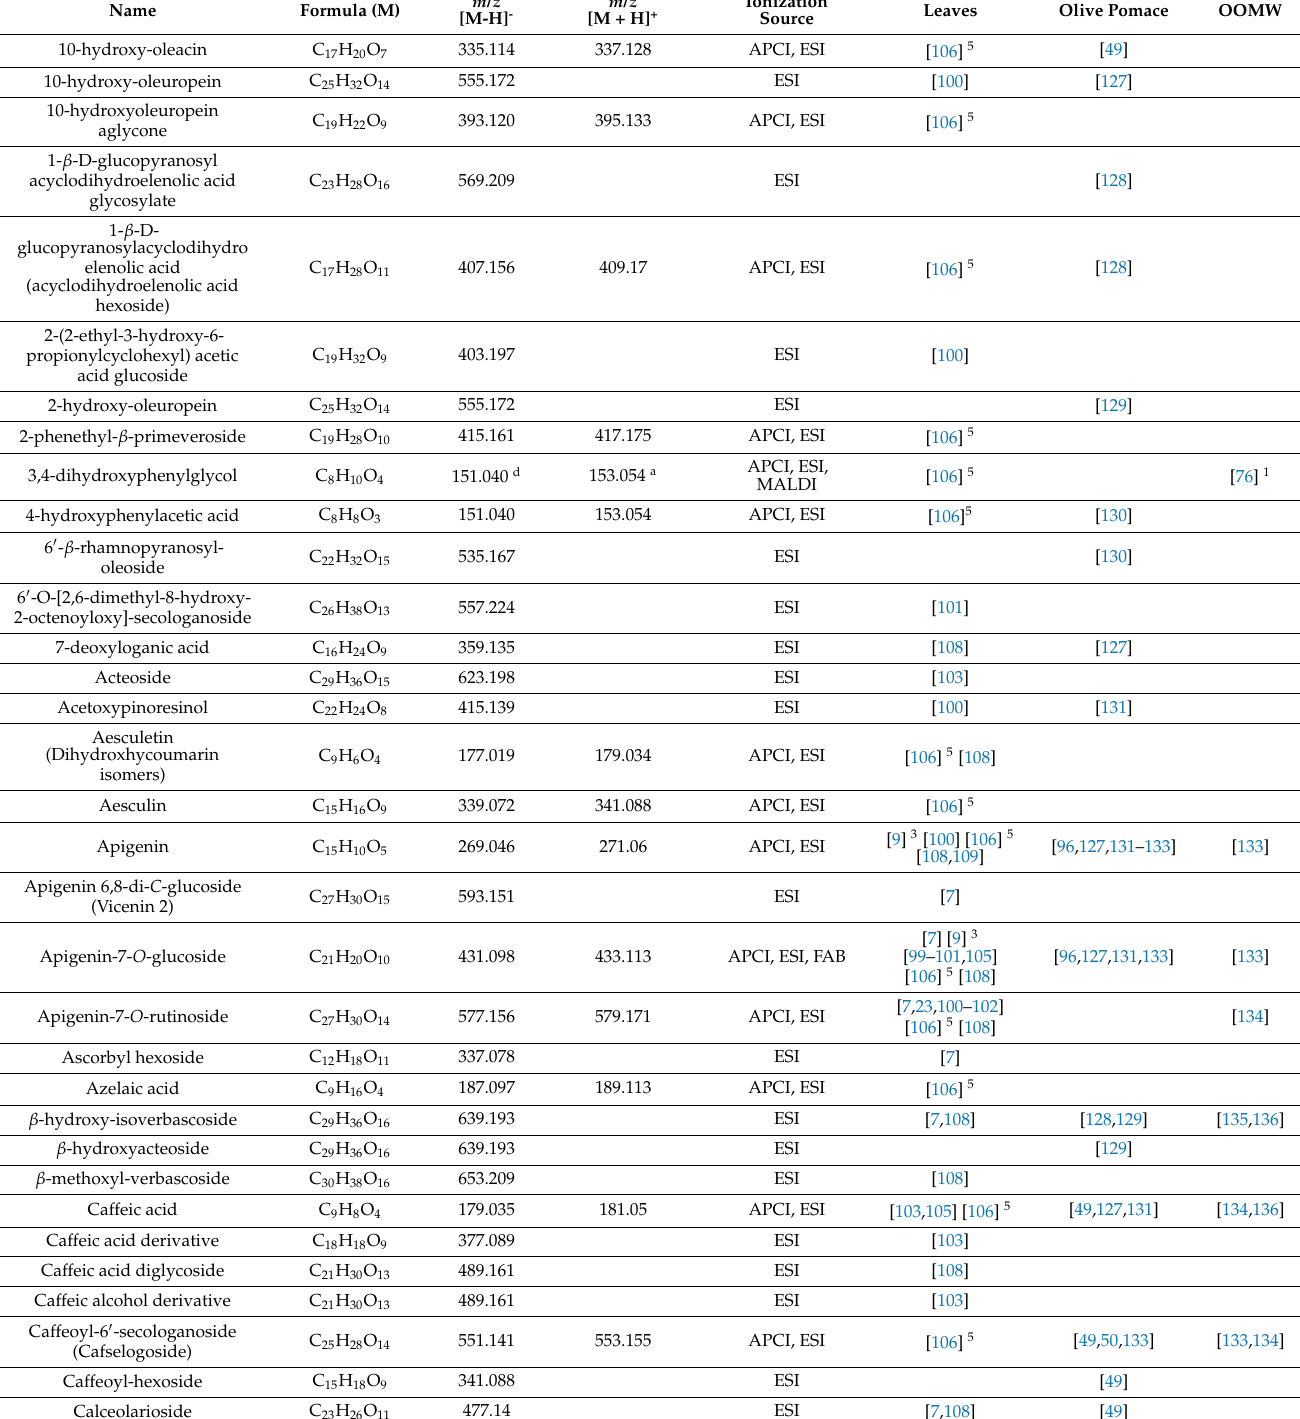
Table 2. List of the most important bioactive compounds detected using mass spectrometry in olive leaves and olive pomace and in olive oil mill wastewater